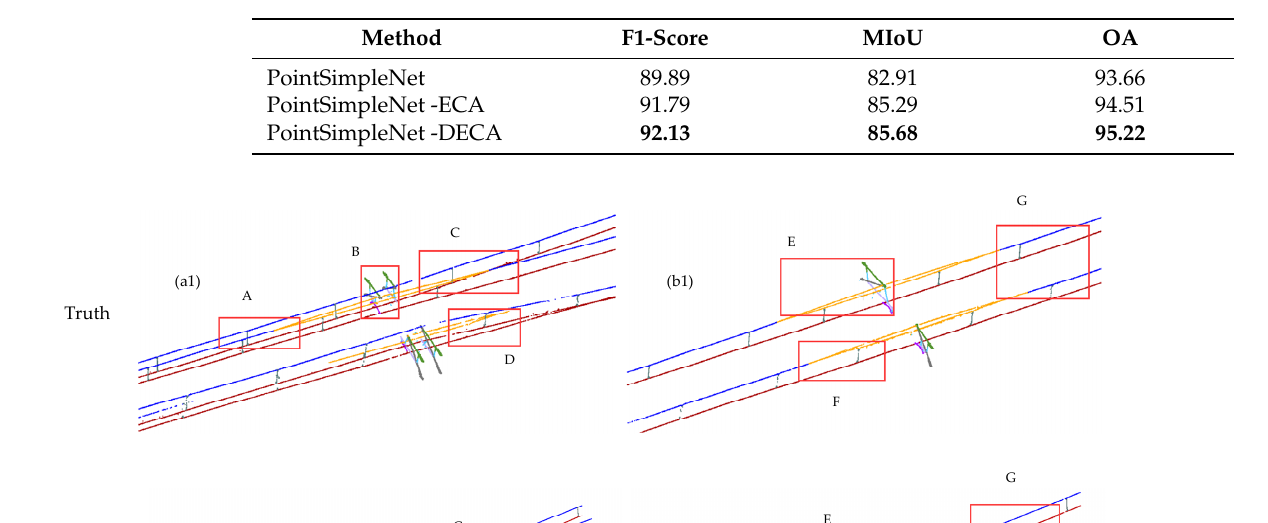
Table 6. Quantitative evaluation of the DECA module through three groups of comparative exper- iments (%) on the OCS point cloud dataset. The best metrics are highlighted in bold. Method